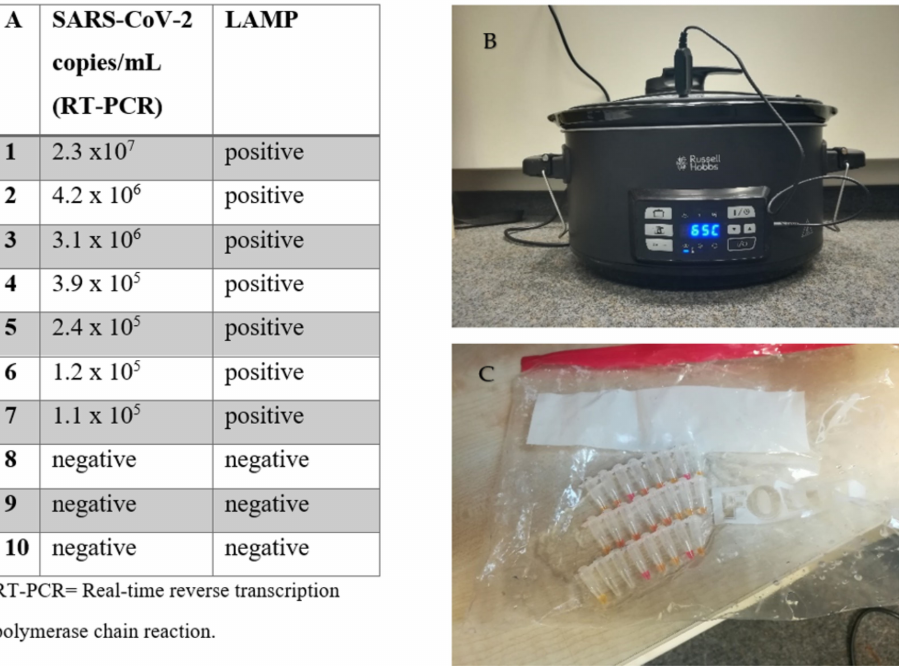
Figure 2. Loop-mediated isothermal amplification (LAMP) assay without a thermocycler. ( A ) Comparison of RT-PCR vs. the LAMP assay performed in a household sous-vide cooking unit. ( B ) Picture of the sous-vide cooking unit during testing, and ( C ) of the samples after completion of the